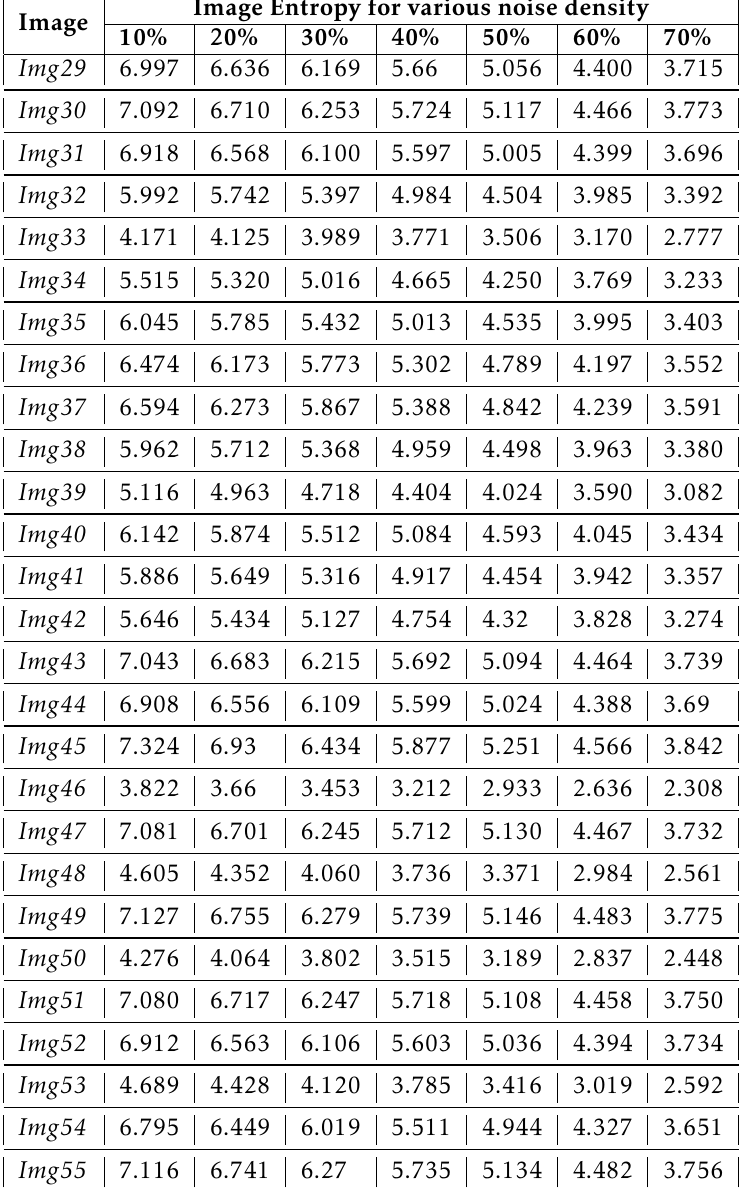
Table 2. Change in entropy with respect to noise density....Continuation Image